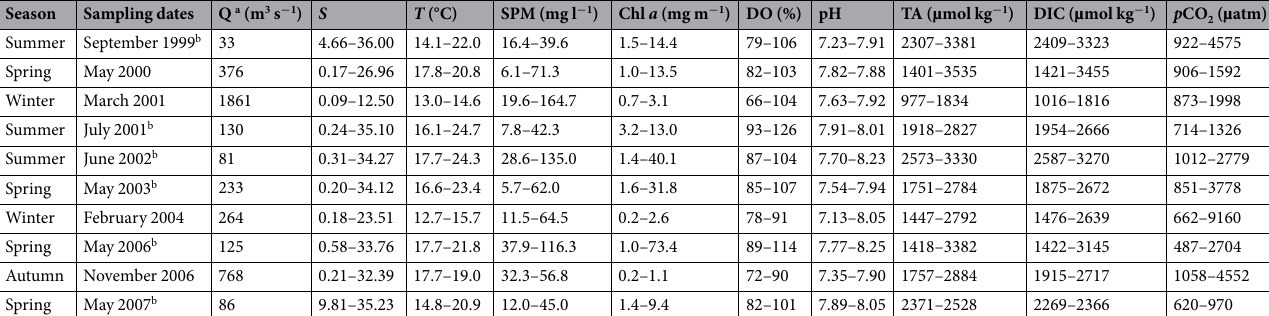
Table 1. Range of physical-chemical and biological properties of surface waters in Tagus estuary for each sampling date. Freshwater flow (Q), salinity ( S ), temperature ( T ), suspended particulate matter (SPM), chlorophyll a (Chl a ), dissolved oxygen (DO), total alkalinity (TA), dissolved inorganic carbon (DIC) and CO 2 partial pressure ( p CO 2 ). a Tagus river flow, taken from Almourol station (the most downstream hydrological